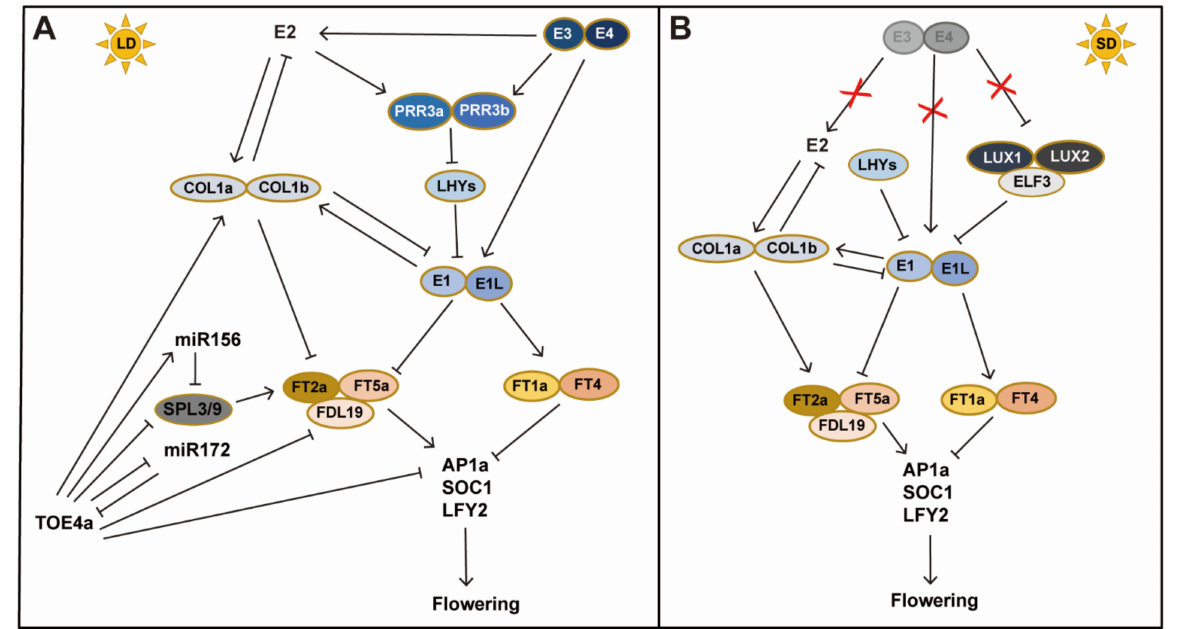
Figure 2. Working models for flowering-time regulation in soybean under long day (LD) and short day (SD). ( A ) Flowering-time regulation of soybean in LDs. Under LD, E3 and E4 upregulate the expression of E1 , E1Lb , E2 , GmPRR3a and GmPRR3b . E1 promotes the expression of the floral inhibitors GmFT1a and GmFT4 , but inhibits the expression of the floral promoters GmFT2a and GmFT5a , and thus the transition to flowering is greatly delayed in LDs. GmFT2a and GmFT5a interact with GmFDL19 to induce the expression of AP1a , SOC1 and LFY , whereas GmFT1a and GmFT4 function to inhibit the expression of these floral promoters to delay flowering. GmPRR3a and GmPRR3b repress GmLHYs expression through binding to their promoter. GmLHYs bind to the E1 promoter to repress E1 expression. The inhibition of E1 expression by GmLHY s is released by the induction of GmPRR3a and GmPRR3b . GmCOL1a and GmCOL1b are soybean flowering inhibitors and repress GmFT2a and GmFT5a expression, and there is a feedback regulation among GmCOL1a , E1 and E2 . E3 and E4 promote the expression of E2 . GmTOE4 a delays flowering by inhibiting the expression of GmFT2a , GmFT5a , GmSPL3/9 and miR172 , and promoting the expression of miR156 , GmCOL1a and GmCOL1b . miR172 negatively feedback regulates its target gene GmTOE4a . GmTOE4a participates in the flowering-regulation pathway that requires E3 and E4 . ( B ) Flowering induction of soybean in SDs. Under SDs, E3 and E4 play a limited role, and E1 expression is also suppressed; hence, the inhibition of GmFT2a/GmFT5a and the induction of GmFT1a /GmFT4 by E1 both are weakened; therefore, flowering is strongly promoted. The expression of E1/E1L is repressed by GmLHY s and GmELF3 . GmELF3 and GmLHY s act additively to control E1 expression. GmELF3 is suppressed by two PHYA proteins, E3 and E4. As the functions of E3 and E4 are greatly weakened under SDs, the inhibition of GmELF3 is released. The GmELF3 protein interacts with GmLUX1 and GmLUX2 to form the evening complex of GmELF3-GmLUX1-GmLUX2. In short, the two molecular regulatory modules: GmELF3/GmLUX1/GmLUX2 -E1/E1L-FT and GmLHYs-E1/E1L-FT , function to induce soybean flowering in